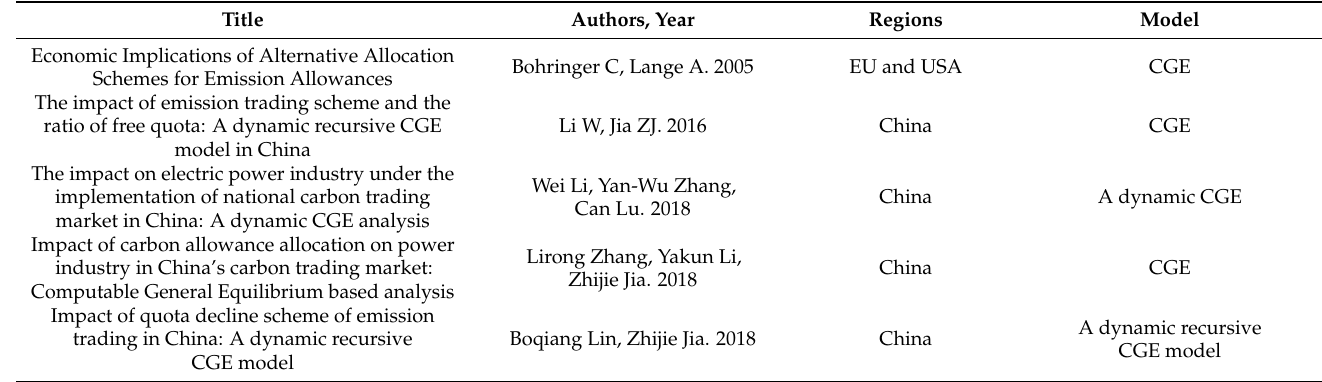
Table 5. Macroscopical research on the impact of allowance allocation in the power industry